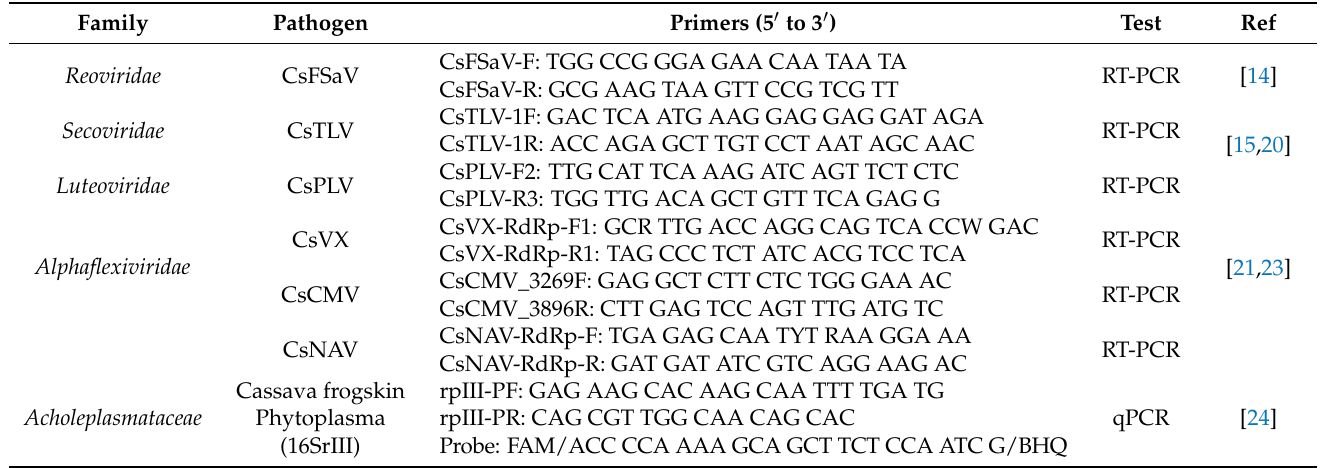
Table 2. List of viruses and phytoplasma detected in plants showing root symptoms of CFSD and the PCR primer sequences used for generic diagnostics by the Cassava Crop Protection team at